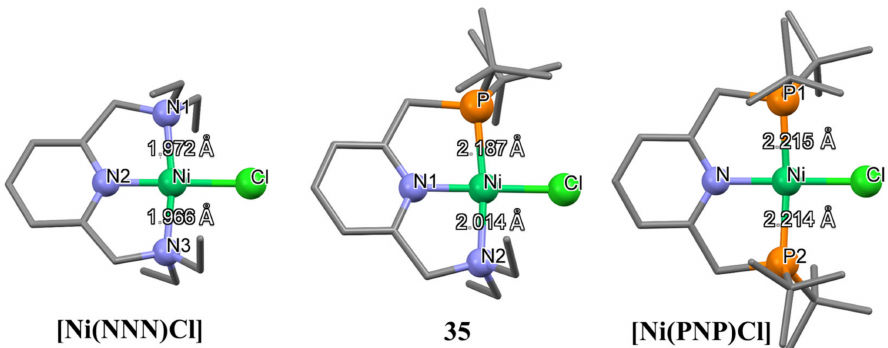
Figure 8. Crystal structures of the cations of nickel NNN and PNP pincers and complex 35